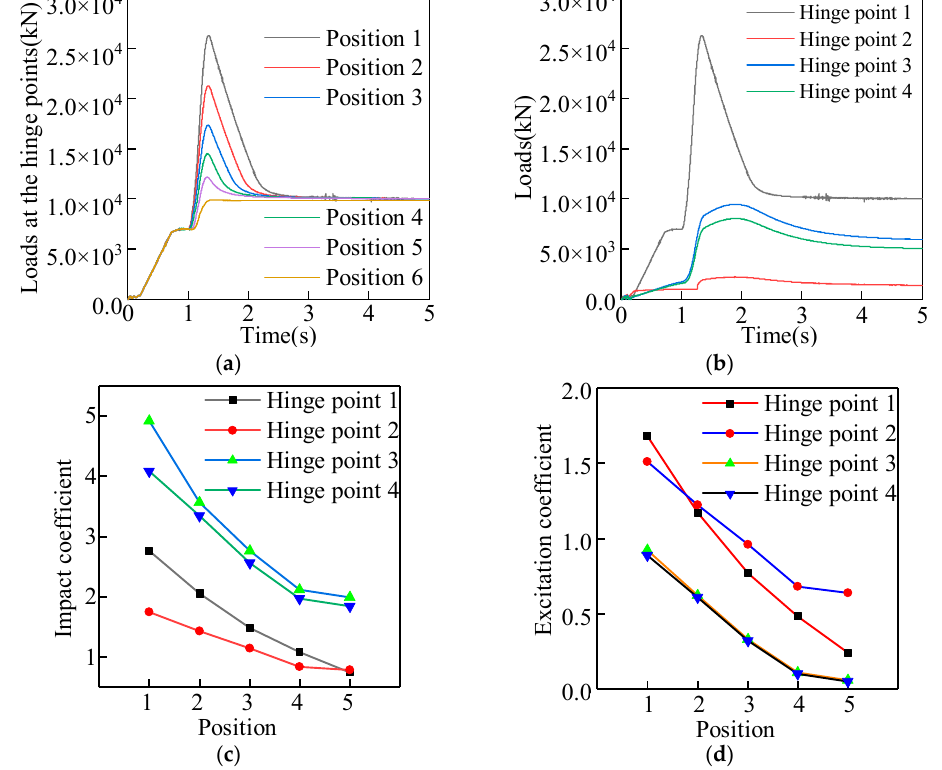
Figure 11. ( a ) Hinged point 1 load at different rotation positions. ( b ) Hinged point loads at different positions. ( c ) Impact coefficient of each hinge point. ( d ) Excitation coefficient of each hinge point.